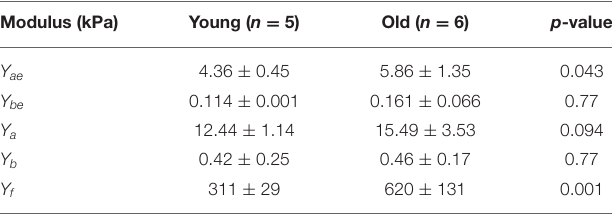
TABLE 2 | Aging results showing mean and standard errors with respective p -values for young and old mice. Modulus (kPa)